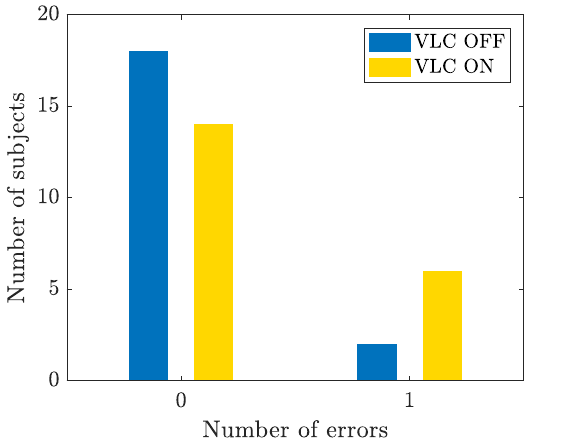
Figure 10. Bar plot representing the number of errors for the Ishihara test with VLC on (yellow bar) and off (blue bar).